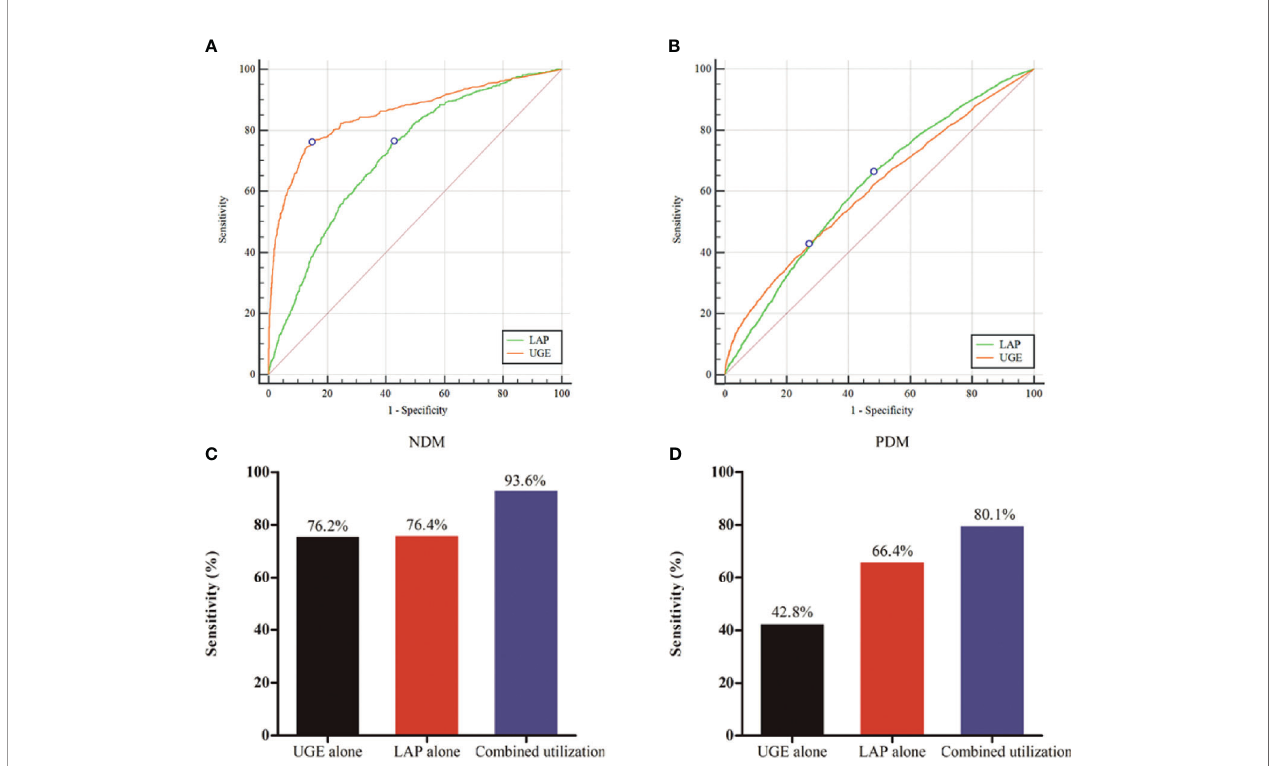
FIGURE 1 | Performance of lipid accumulation product (LAP) and urine glucose excretion (UGE) in predicting for newly diagnosed diabetes (NDM) and prediabetes (PDM). (A) Receiver operating characteristic (ROC) curve for identifying NDM. (B) ROC curve for identifying PDM. (C) Evaluation of LAP combined with UGE for identifying NDM. (D) Evaluation of LAP combined with UGE for identifying PDM.